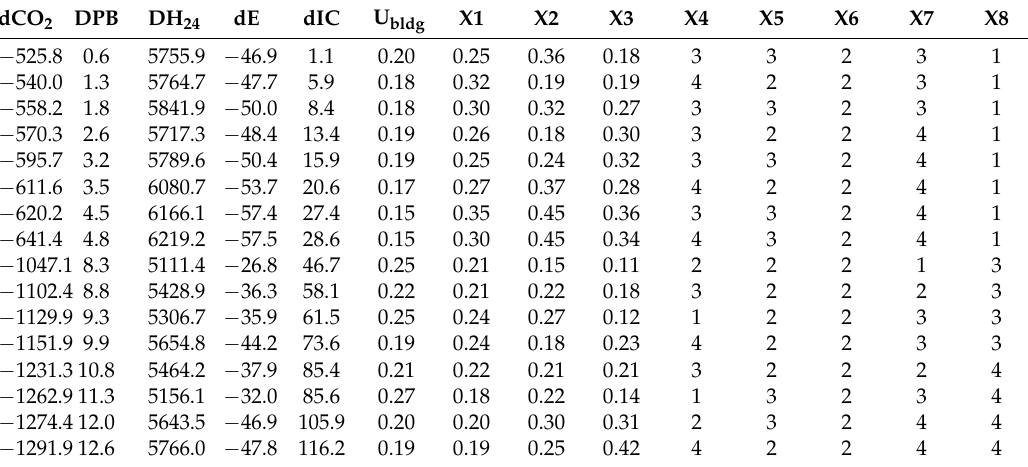
Table A2. Optimal Pareto solutions for Case 2 ( P